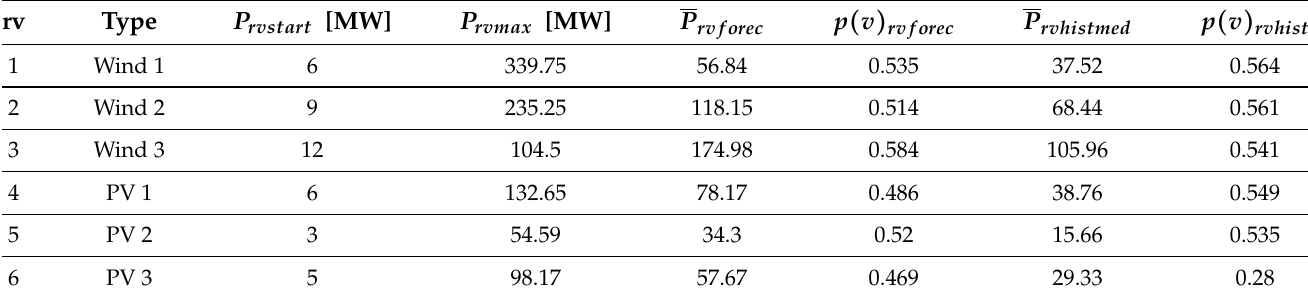
Table 4. Parameters of NCRES